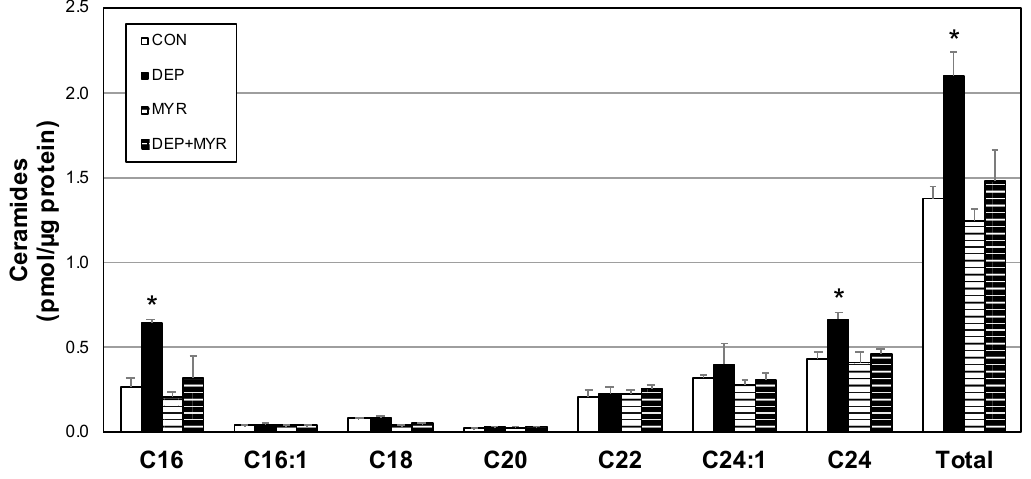
Figure 4. Diesel exhaust particle exposure increases ceramides in primary alveolar macrophage ceramides. Ceramides were quantified in primary alveolar macrophages after treatment with control media (CON), DEP, myriocin (MYR), or DEP + MYR for 12 h. n = 4. * p < 0.05; DEP vs. other conditions. Primary alveolar macrophages responded to DEP in a similar manner as before, with reduced